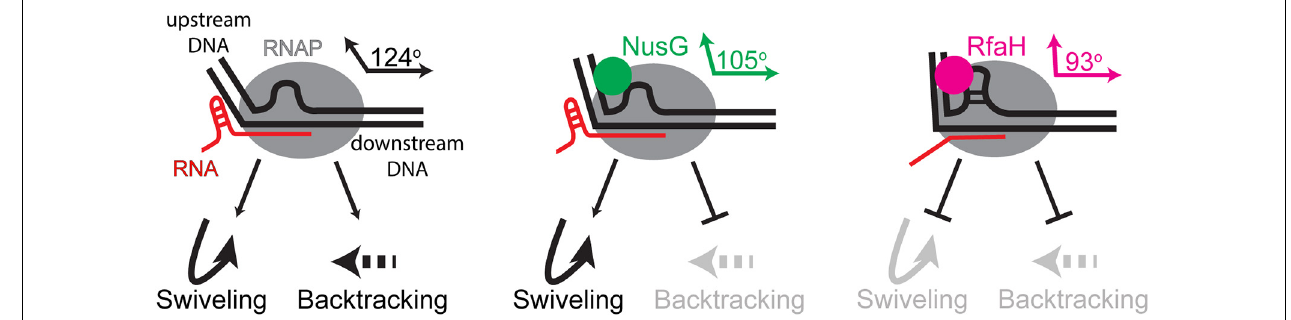
FIGURE 5 | Antipausing activities of E. coli NusG and RfaH. Upon encountering a pause-inducing sequence, RNAP can either backtrack or undergo conformational changes termed swiveling; the latter are stabilized by formation of a pause hairpin in the nascent RNA. The NGN domains of both proteins bind near the upstream edge of the transcription bubble, promoting forward and thus inhibiting backward translocation. Transient (NusG) or stable (RfaH) interactions with the non-template DNA strand bring the upstream and downstream DNA duplexes closer together (indicated by angles between these duplexes), an effect that is more pronounced with RfaH. RfaH also binds to the β ’ and β subunits with higher affinity, restricting the clamp movements to inhibit swiveling and hairpin-stabilized pausing. NusG lacks this activity.